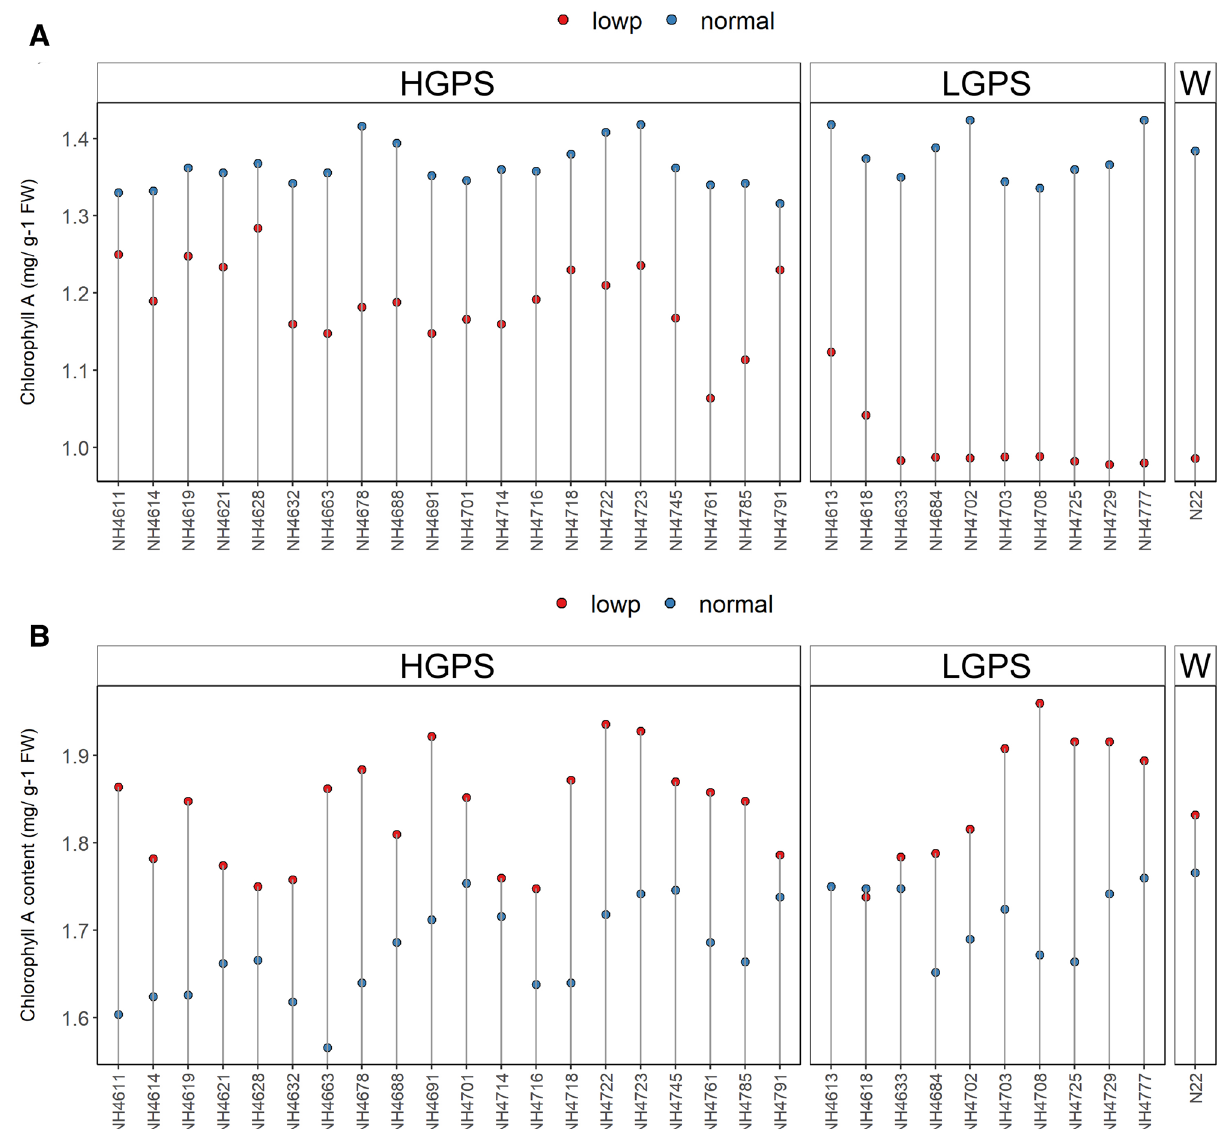
Figure 7. Chlorophyll a (Chl a) content of seedlings obtained from germination of seeds harvested from low P (shown as red dots) and normal P (shown as blue dots) fields. Wild type N22 (W), high grain P mutant seedlings (HGPS), and low grain P mutant seedlings (LGPS) were grown under normal P condition. ( A ) Chl a at 12 days of germination. ( B ) Chl a at 24 days of germination. The values represent the mean of 6